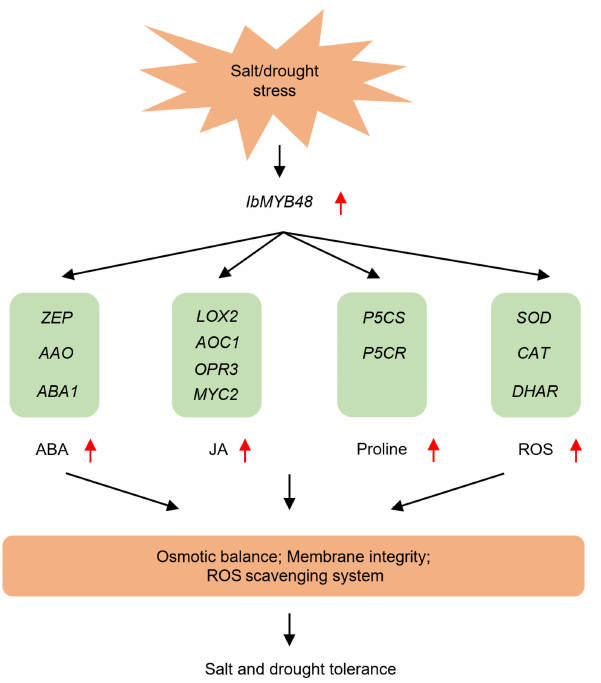
Figure 9. The proposed regulatory network model of IbMYB48 conferring salt and drought tolerance. Under salt or drought stress, the expression level of IbMYB48 gene is induced. Elevated expression of IbMYB48 up-regulates the genes involved in the ABA, JA and proline biosynthetic or signaling pathways. As a result, the contents of ABA, JA, and proline are elevated, meanwhile, the ROS scav- enging system is activated, thus improving salt and drought resistance in plants through maintaining osmotic balance and membrane